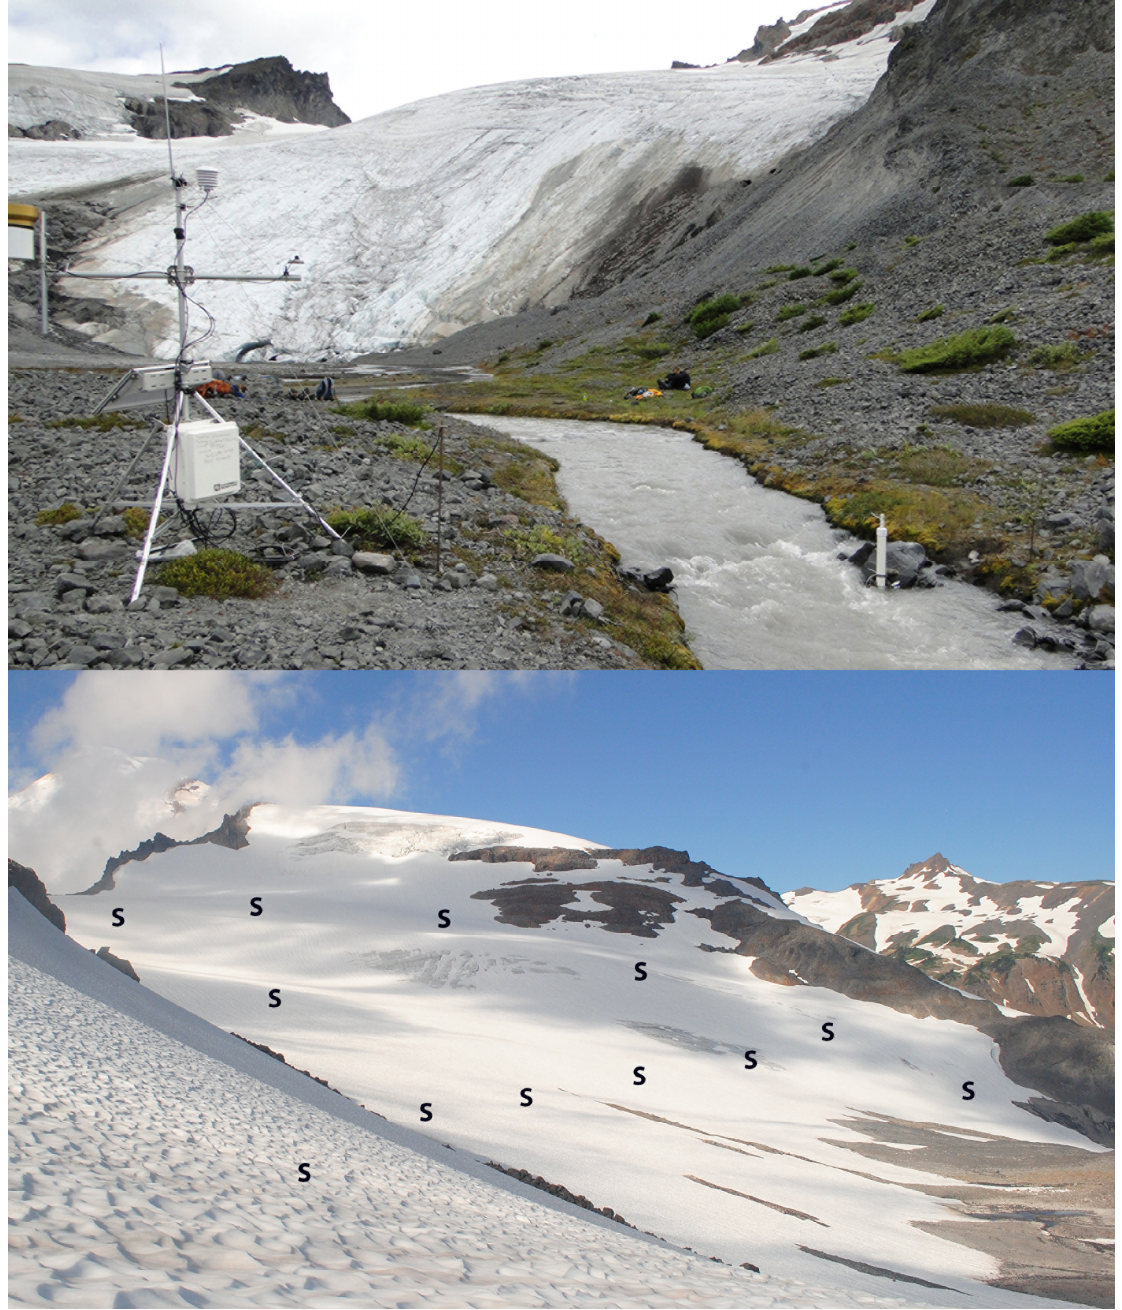
Figure 3. Limited retained snow cover on 8 August 2015 on Sholes Glacier above, with the discharge and weather station in foreground. Below is the stake network on Sholes Glacier annotated on this 2014 image.